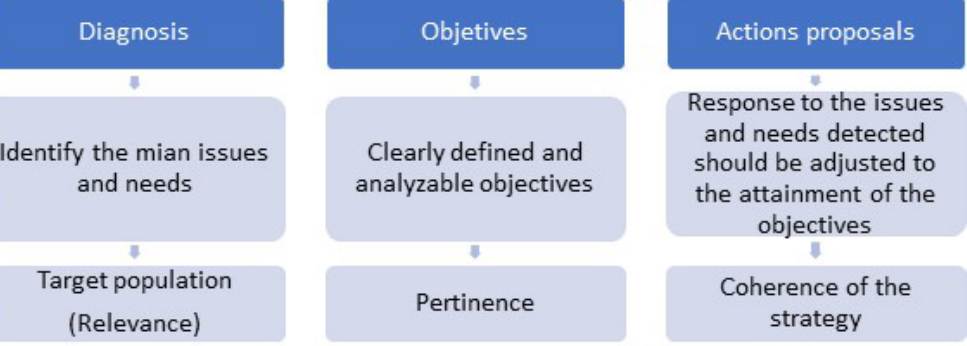
Table 4. Diagnosis of the students’ work “Everyone's Responsibility: Pet Spreading” by Pio XII Pri- mary School.